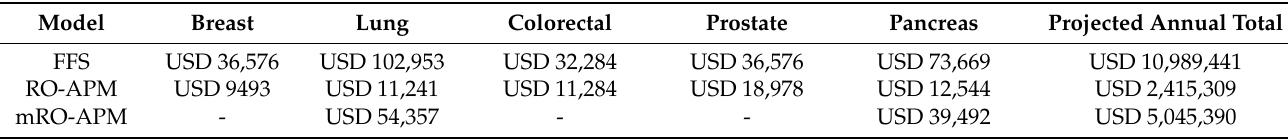
Table 1. Per case reimbursement for selected cancer diagnoses under each reimbursement model and projected annual reimbursement based on model patient population. Abbreviations: fee-for-service, FFS; Radiation Oncology Alterative Payment Model, RO-APM; m,